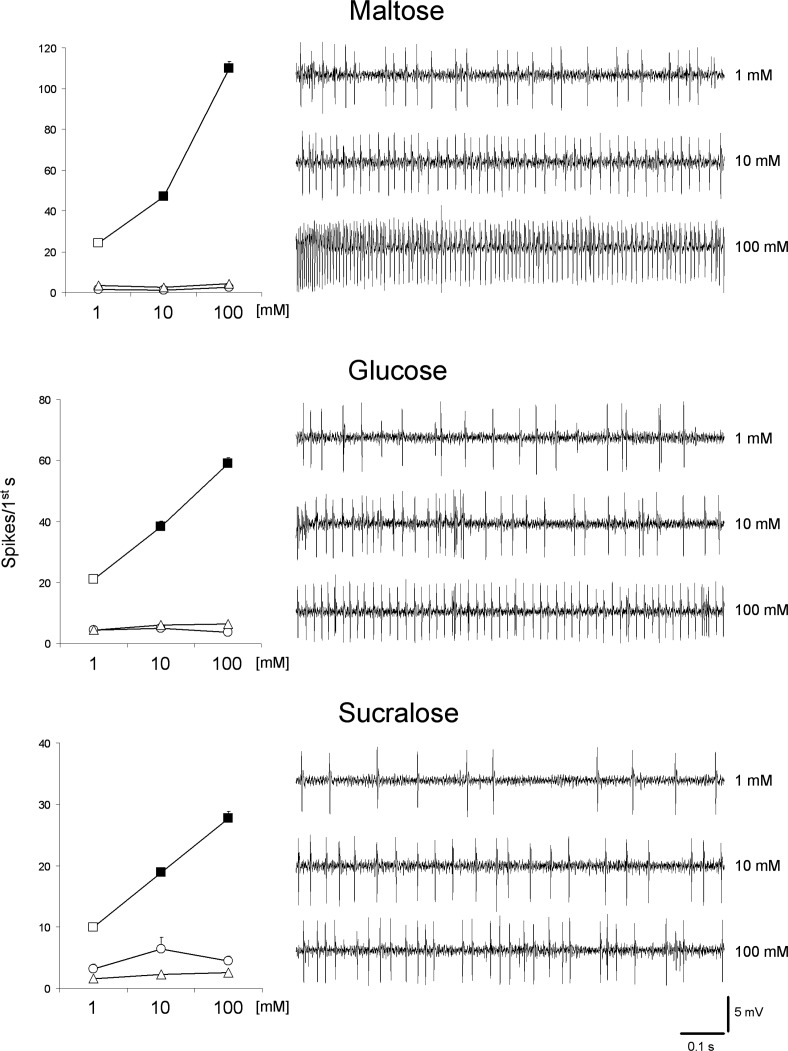
Characterization of sugar GRN in "l" type sensilla.Samples of spike discharges and dose-response relationship between spike activity of GRNs of an "l" type sensillum and 1÷100 mM maltose, glucose and sucralose. Mean values ± s.e.m. N = 32–34. Filled symbols indicate significant differences between a concentration and the next lower (P<0.001; Tukey test subsequent to repeated measures ANOVA). Different spike types are indicated by the following symbols: square = "L" spike; triangle = "M" spike; circle = "S" spike.